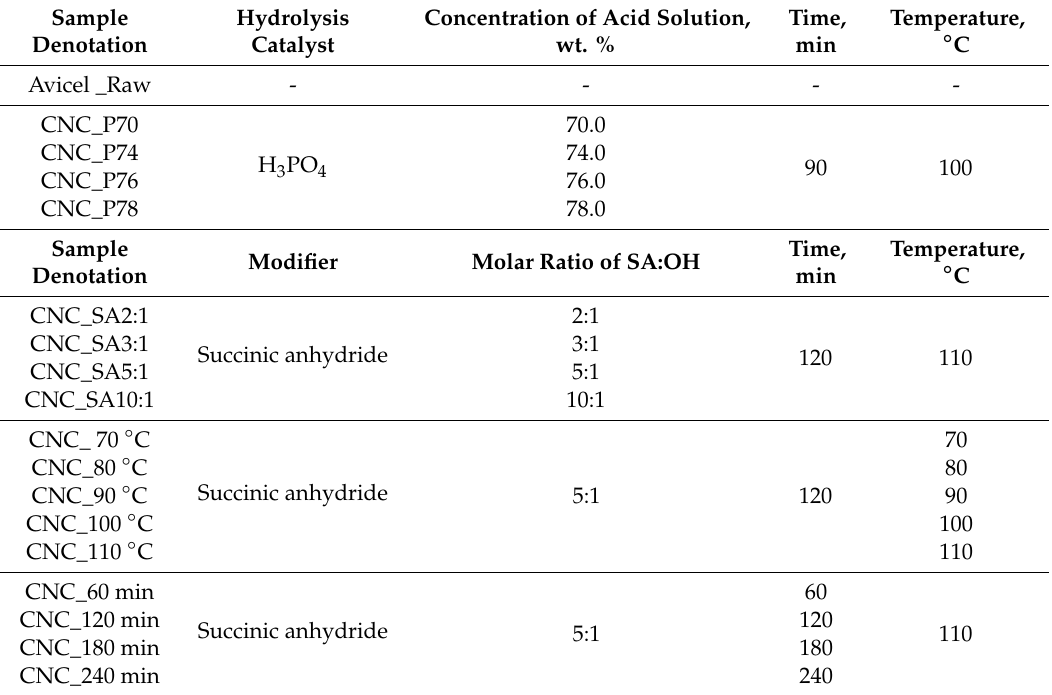
Figure 1. Schematic illustration of the preparation route of modified cellulose nanocrystals. Table 1. Description of prepared